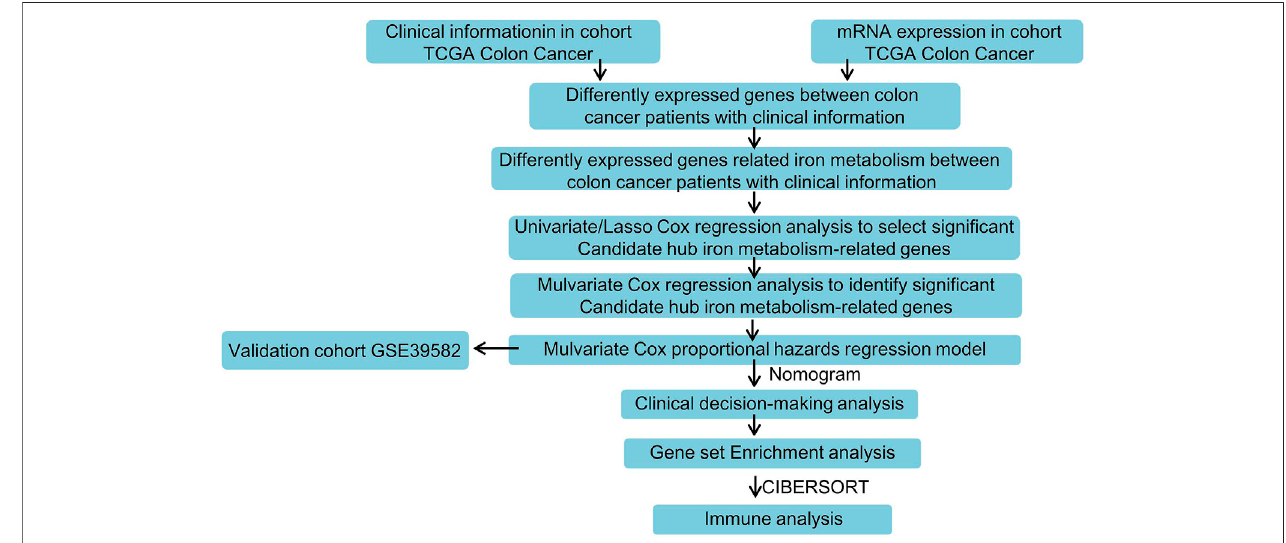
FIGURE 1 | Flowchart for analyzing iron metabolism-related gene signature associated with colon cancer.